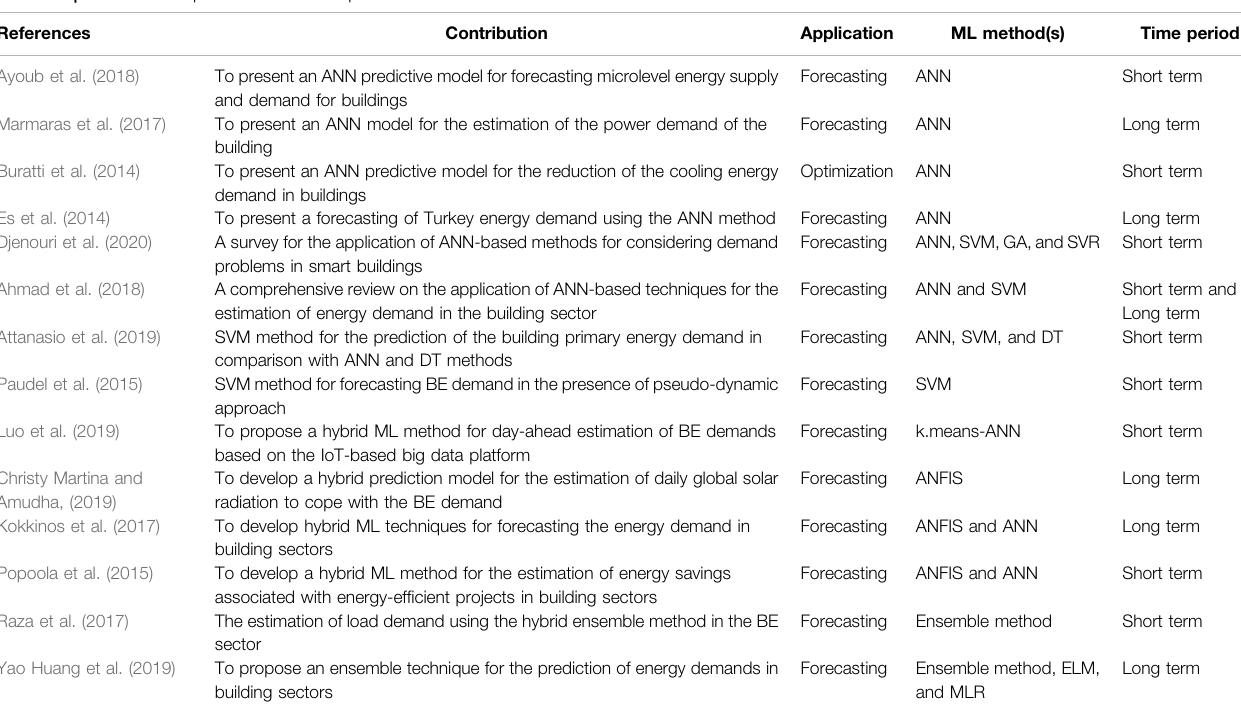
TABLE 1 | Studies developed for BE demand